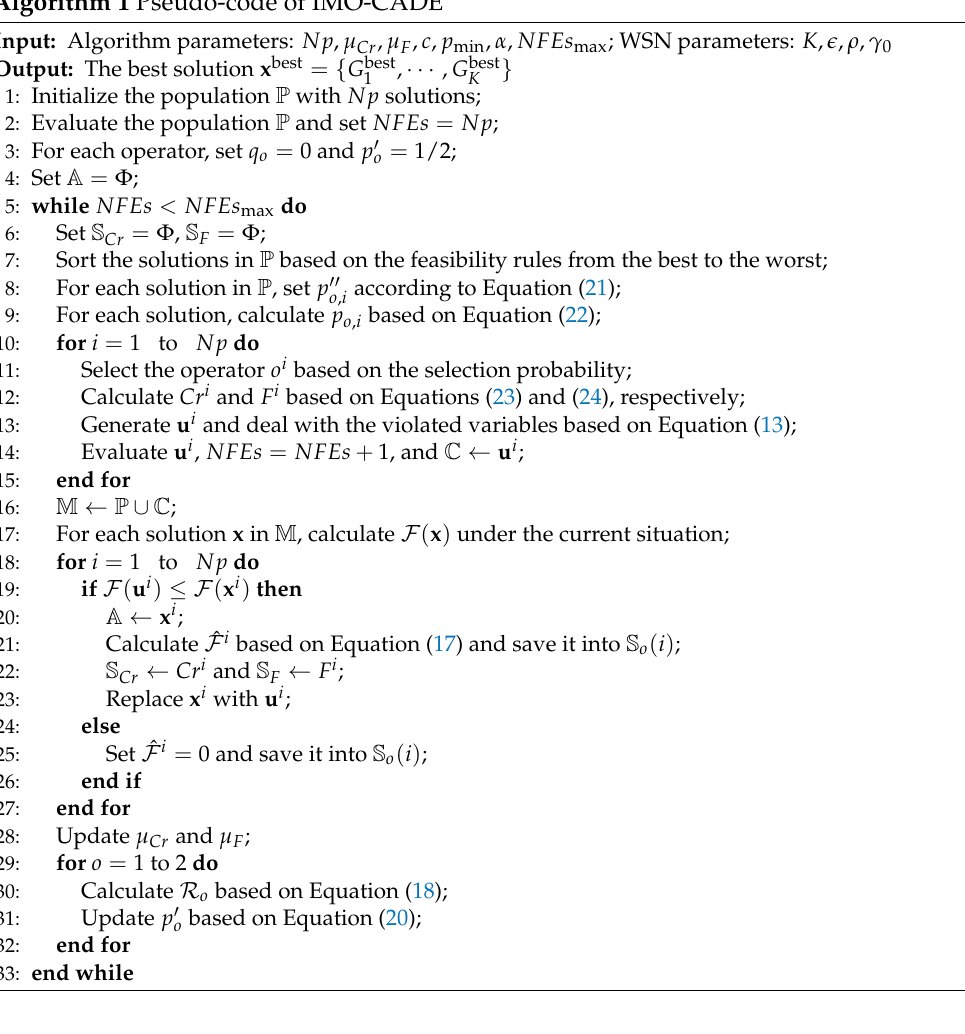
Algorithm 1 Pseudo-code of